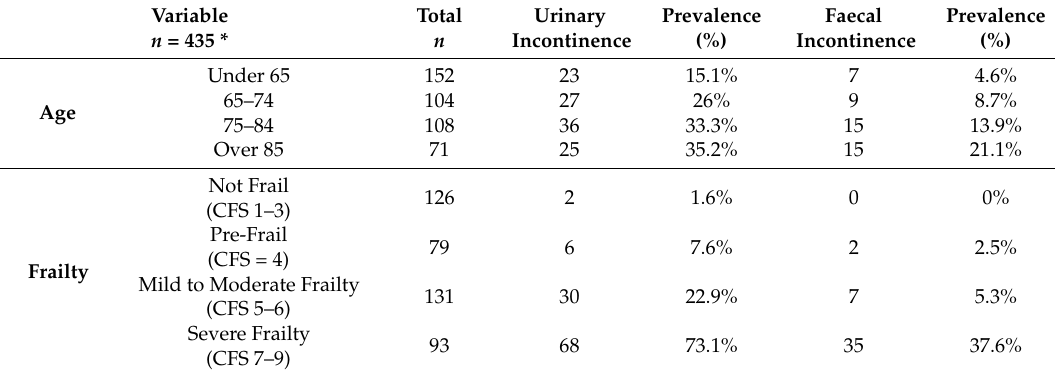
Table 2. Prevalence of Urinary Incontinence and Faecal Incontinence according to age and Clinical Frailty Scale score.